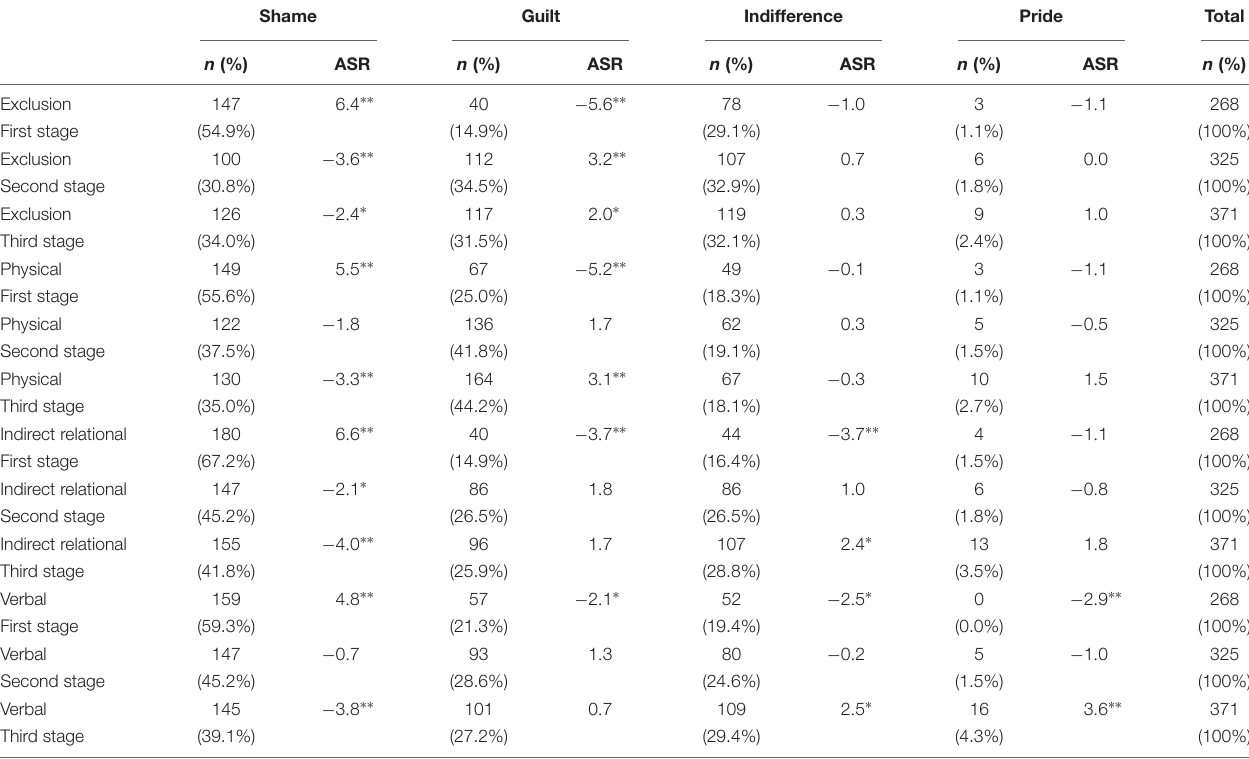
TABLE 7 | Percentages of moral self-attribution and the educative cycle.